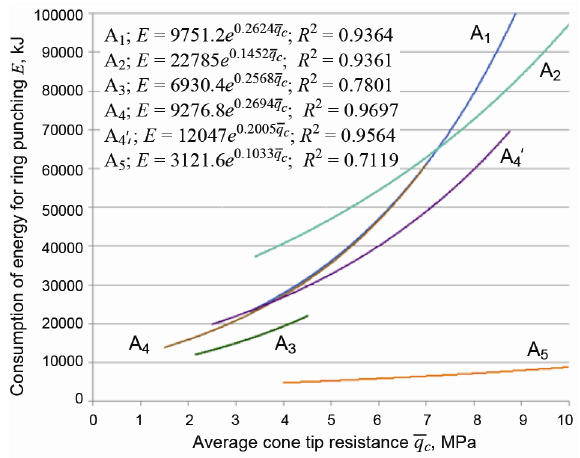
Fig. 9. Influence of soil conditions on the consumption of ener- gy for ring punching, using the exponential dependence regres- sion equation The coefficient of determination R 2 for linear equa- tions varies from 0.69 to 0.97. The coefficient of deter- mination R 2 for exponential equations varies from 0.71 to 0.97. It is obvious that the regression equations of